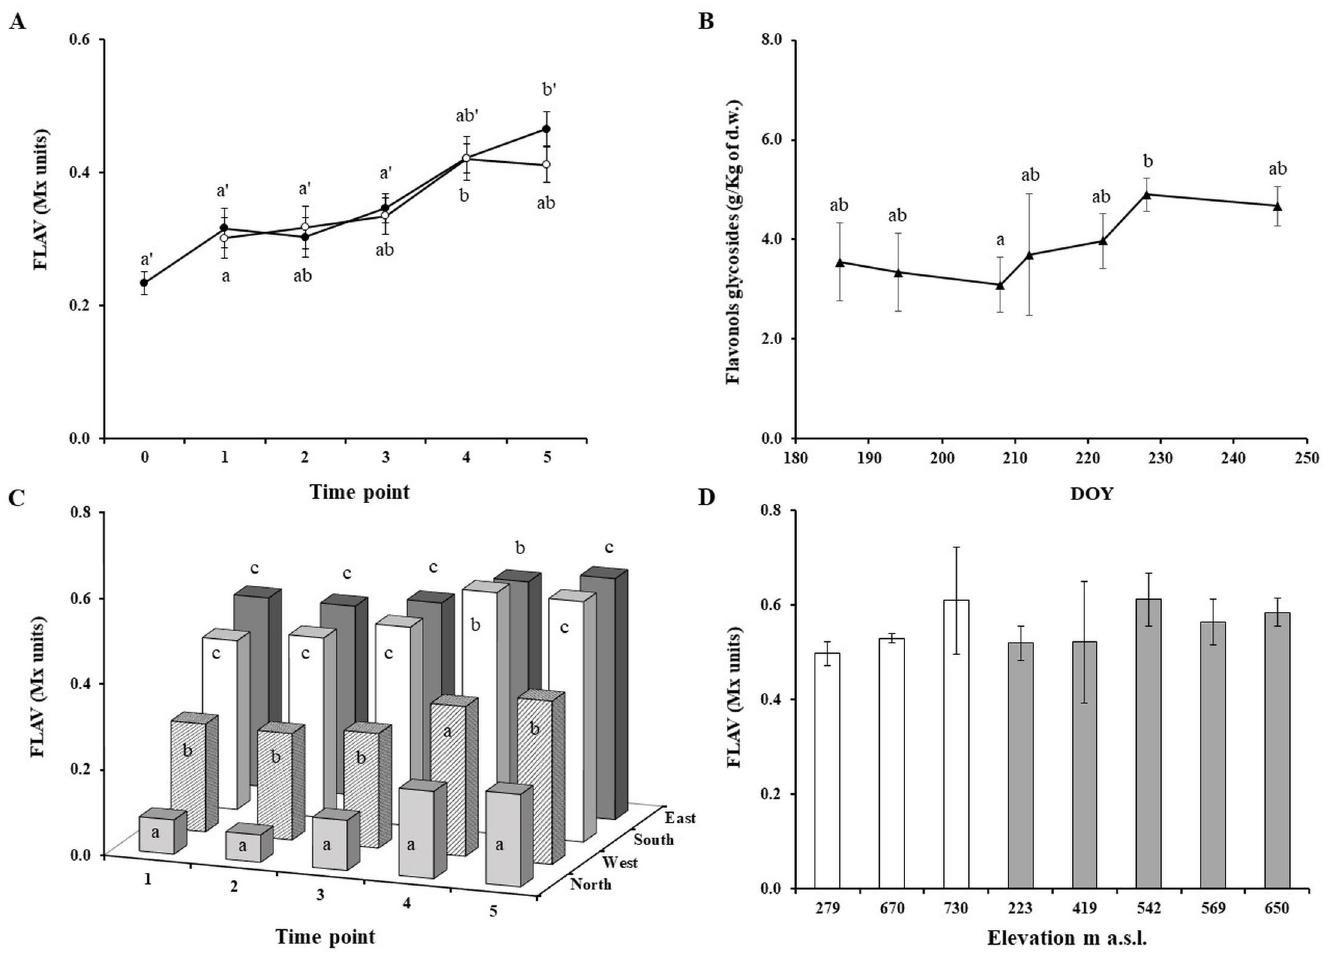
Fig 3. Dynamics of flavonols in Pinot Blanc grape skin during the grape development period and site effect. Trends of FLAV index (Mx units) recorded in the 2017 ( � ) and 2018 (•) vintages (A). Each point represents the mean ± standard error calculated as the pool of eight and seven vineyards, in 2017 and 2018, respectively at six different time-points (0, DOY185; 1, DOY 200–201; 2, DOY 212–214; 3, DOY 228; 4 DOY 242–243; 5, DOY 254–256). Trend of the total amount of flavonol glycosides extracted from the Pinot blanc skin in Tr-1 (2018) (B). Data are expressed as absolute amounts (g/kg grape skin d.w.). Each point represents the mean ± standard error of six replicates. Site effects on flavonol amount, evaluated as: Grape bunch localisation on the row (C), and site elevation (D). The elevation effect was evaluated per group of grape-bunch exposure: South-oriented (white bars), east-oriented bunches (grey bars). Each point represents the FLAV average value calculated as the pool of measurements done in 2017 and 2018 for each time-point (1 to 5 for grape-bunch localisation, and 5 as representative for elevation). Different letters indicate significant differences according to Tukey’s test ( α = 0.05) among time (A, B) and according to Dunn Bonferroni test ( α = 0.05) for bunch localisations or elevation (C, D).